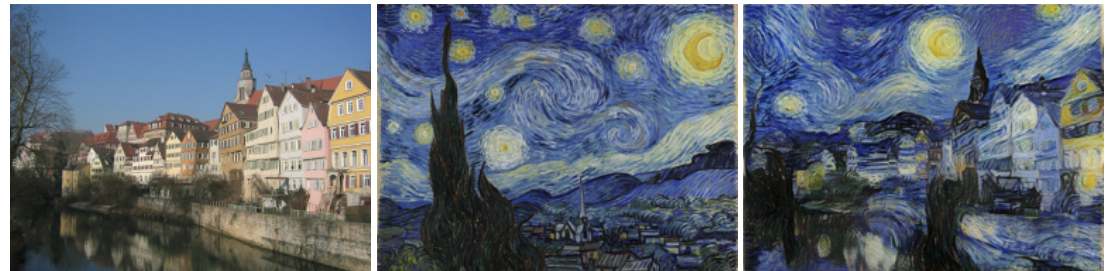
Figure 8. The Neural Style Transfer Algorithm (Gatys et al. 2016), which stylizes a photograph in the style of a given artwork; in this case, Van Gogh’s The Starry Night . This algorithm has led to numerous new apps and research in stylization. Van Gogh image in public domain; images by Leon Gatys, used by permission.